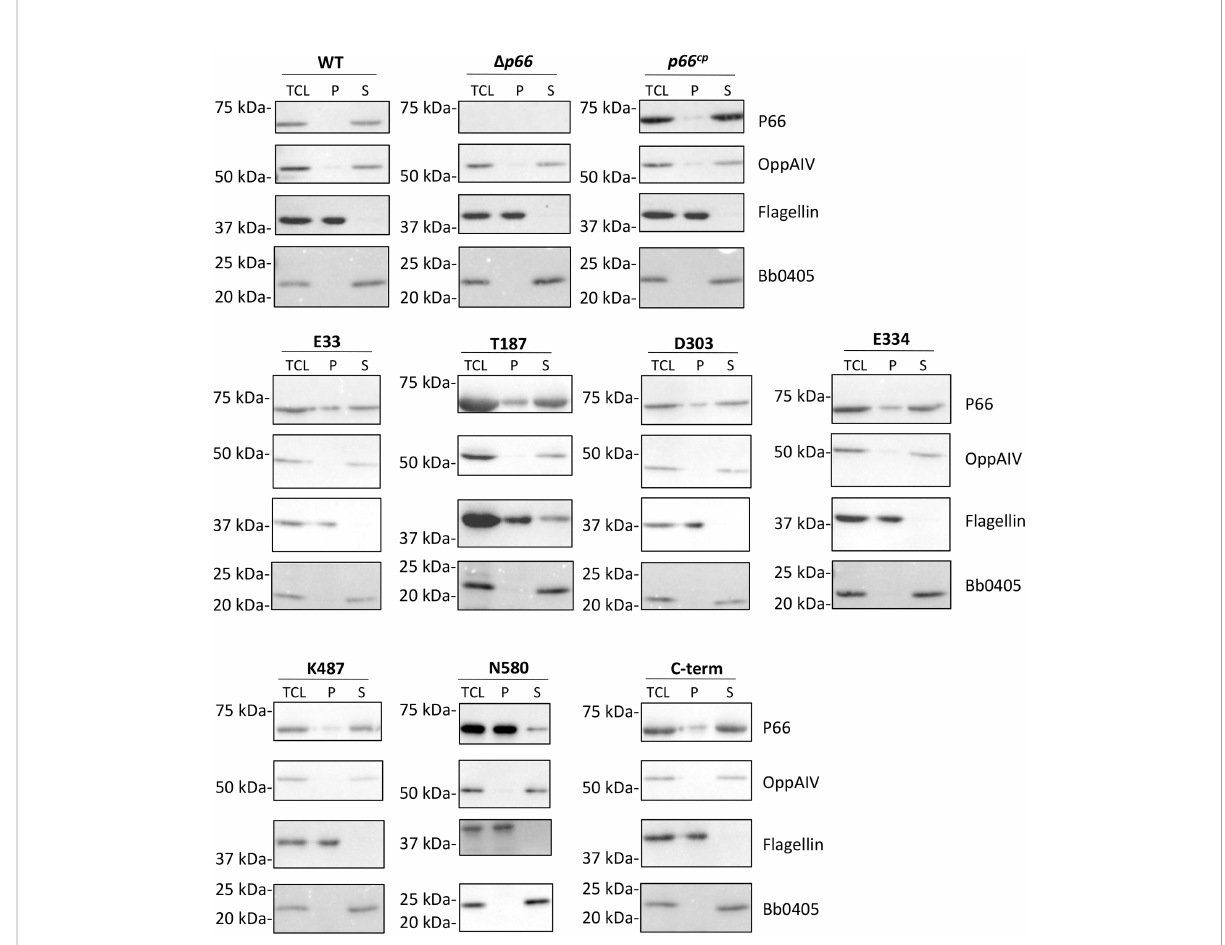
FIGURE 2 Non-ionic detergent extraction of P66. B31 A3 WT, D p66 , and derivative strains (B31 A3 c-Myc P66 cp ) were treated with HEPES buffered saline and octyl b -D-glucopyranoside at 4°C for 2 hours. Total cell lysate (TCL) was centrifuged to separate pellet (P) and supernatant (S) fractions. Fractions were subjected to SDS-PAGE and western blotting for the indicated proteins. Representative images are